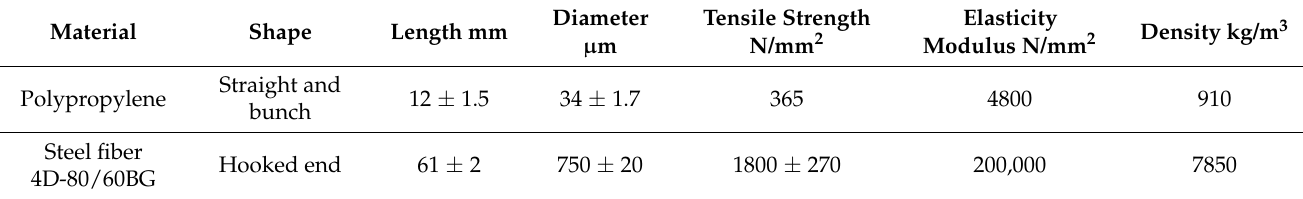
Table 1. The properties of fibers used in the experiment.